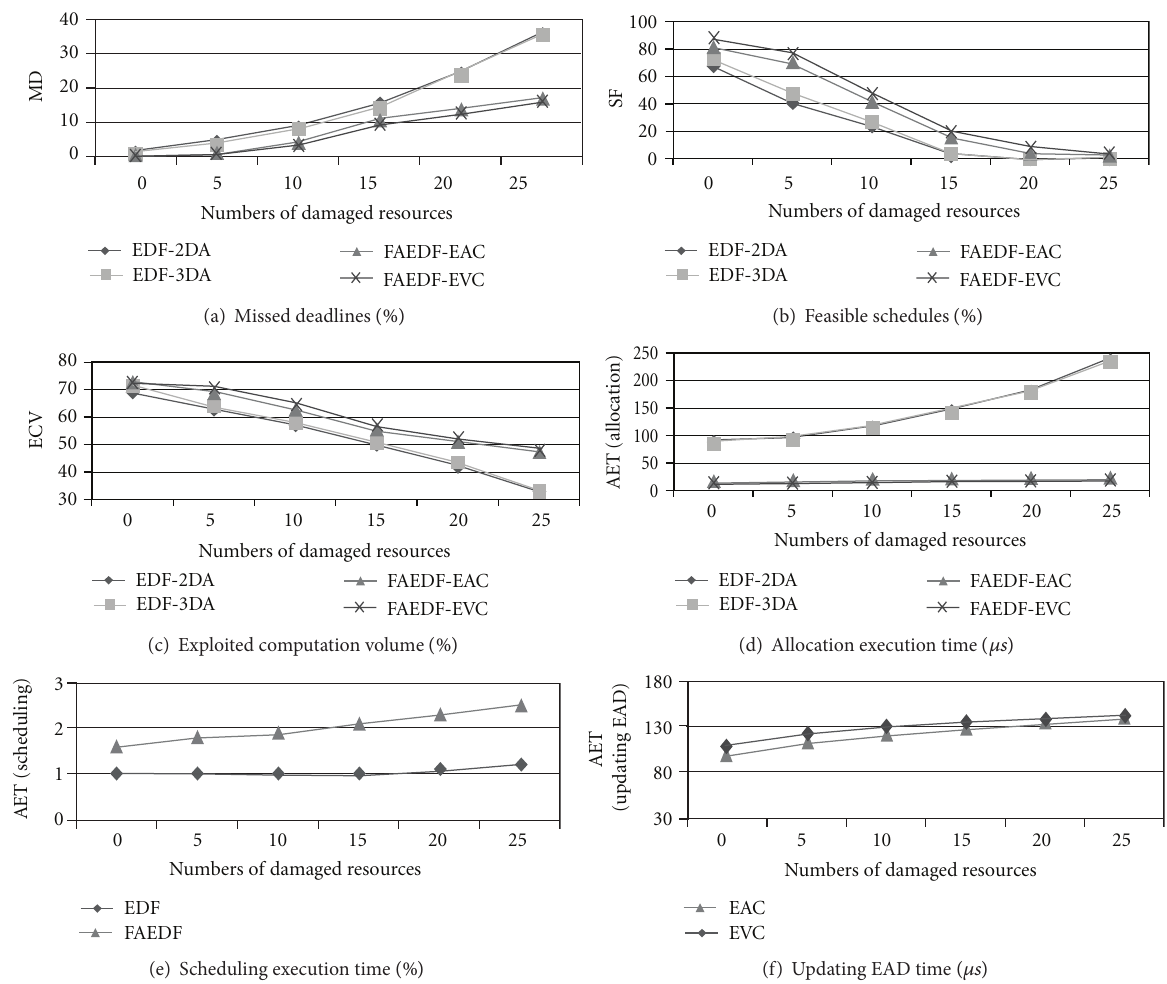
= 0.5 and 𝑈 = 0.9 ICAP COMP